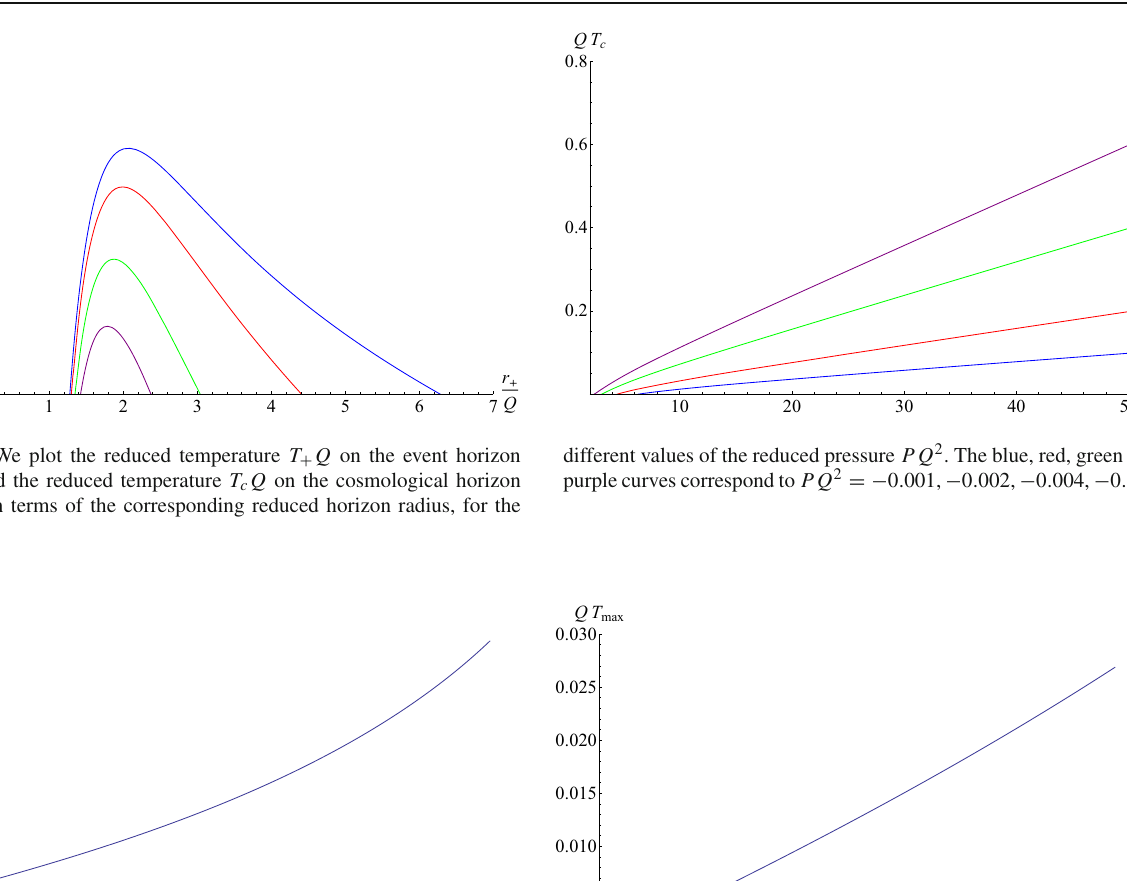
maximum temperature T max is a unique positive real solution of the following